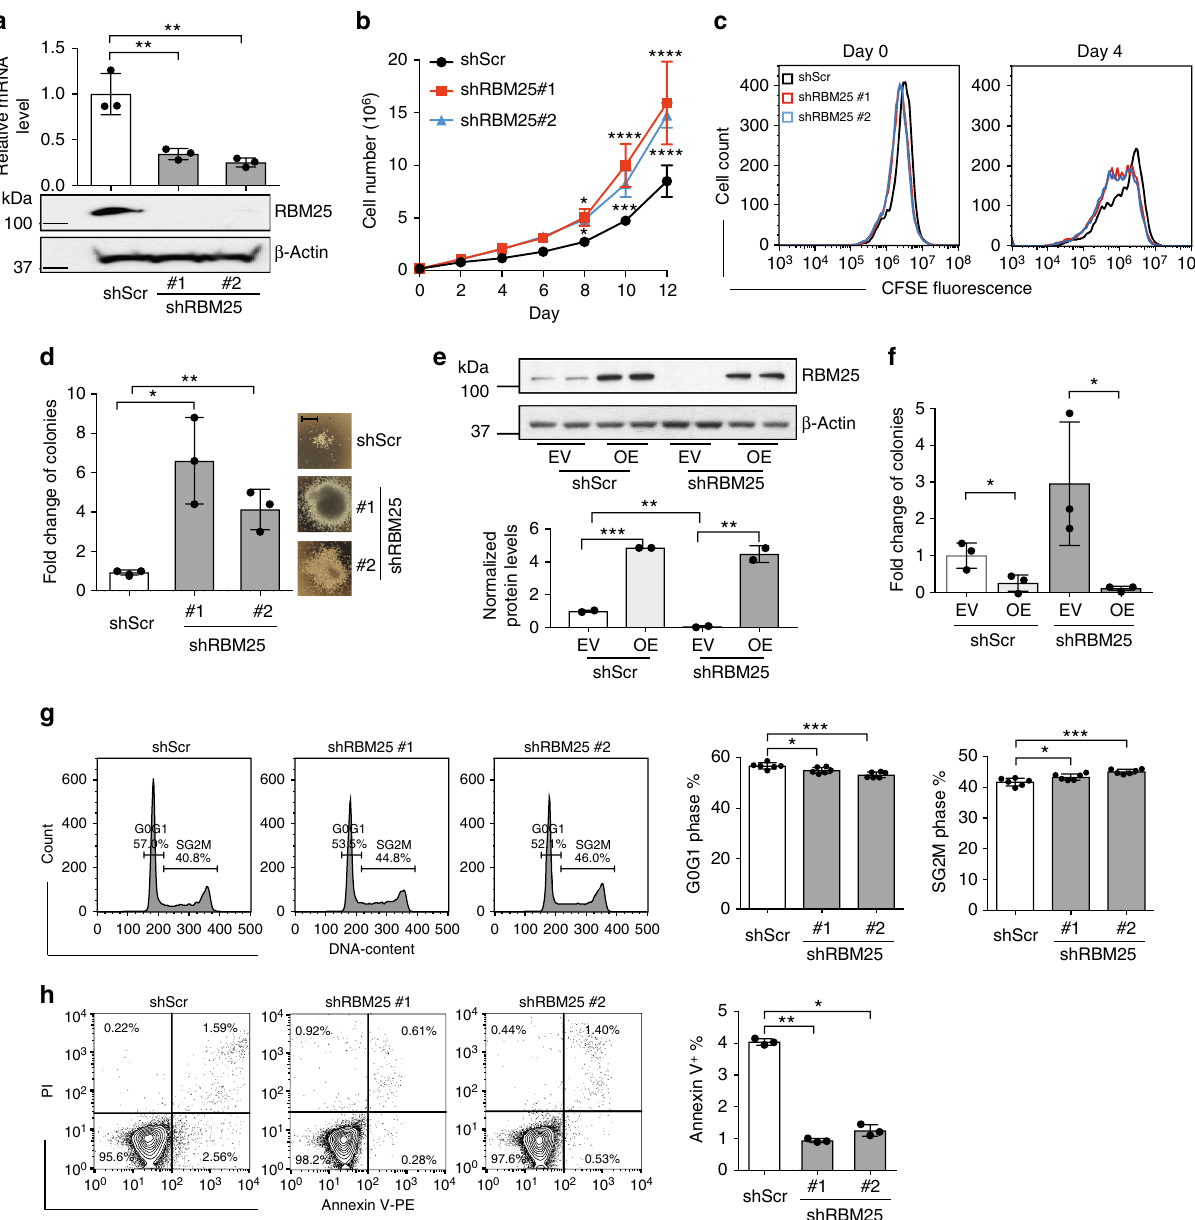
Fig. 3 RBM25 restricts the growth of human leukemic cells. a RBM25 KD ef fi ciency in U937 cells with two RBM25 speci fi c shRNAs (shRBM25#1 and shRBM25#2), as analyzed by qPCR (upper panel, data represent the mean ± s.d., n = 3) and western blot (lower panel). b Proliferation of U937 cells transduced as in ( a ) (data represent the mean ± s.d., n = 3). c CFSE retention in U937 cells transduced as in ( a ). d Colony-forming potential of U937 cells transduced as in ( a ) (data represent the mean ± s.d., n = 3). Representative colony morphology is shown next to the graph. Scale bar represents 200 μ m. e Overexpression of RBM25 in U937 cells with shRNA resistant analyzed by western blot (upper panel). Relative band intensities were quanti fi ed by ImageStudioLite and normalized to EV + Scr (lower panel). f Rescue of the effect of RBM25 KD on colony-forming capacity by overexpression of RBM25 (data represent the mean ± s.d., n = 3). g Cell cycle analysis of U937 cells transduced as in ( a ) assessed by PI staining. Left panel shows representative FACS histograms of cell cycle analysis whereas right panel shows quantitative summary of the G0G1 and SG2M phases (data represent the mean ± s.d., n = 6). h Apoptosis assessed by fl ow cytometry using Annexin V/PI staining. Left panel, representative FACS histograms of the cell cycle analysis. Bar plots on the right are quanti fi cations of the Annexin V + cells after RBM25 KD (data represent the mean ± s.d., n = 3). Data were subjected to an unpaired t test and asterisks indicate the following: * P < 0.05; ** P < 0.01; *** P < 0.001; **** P < 0.0001. All panels show representative results of ≥ 2 independent experiments. All replicates in ( a ), ( b ), ( d ), ( e ), ( f ), ( g ), and ( h ) are biological